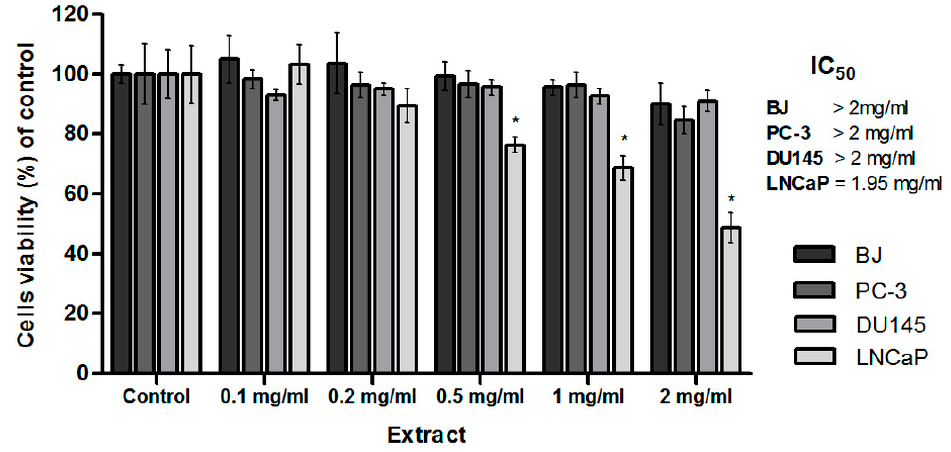
Figure 4. Skin fibroblast cell line (BJ) and three prostate cancer cell lines (PC-3, DU145 and LNCaP) viability (% of control) based on the MTT assay treated with CA extract. The cells were treated with an extract in a wide range of concentrations (2–0.1 mg/mL) or DMSO as a vehicle in control cultures for 48 h. The values were presented as mean ± SD derived from three independent experiments. * p ≤ 0.05.